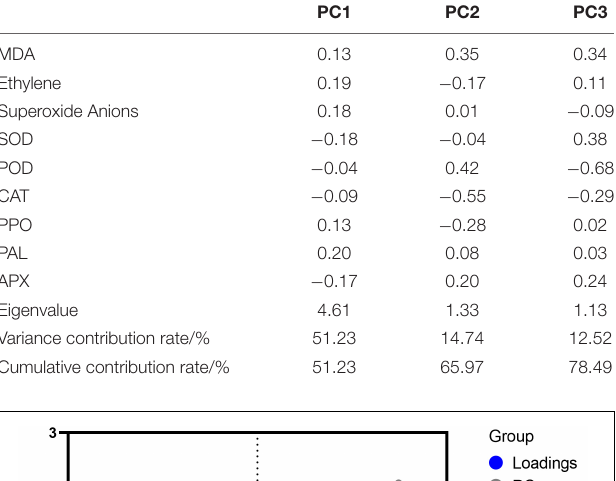
TABLE 3 | Principal component analysis of the antioxidant system on storage day 10.